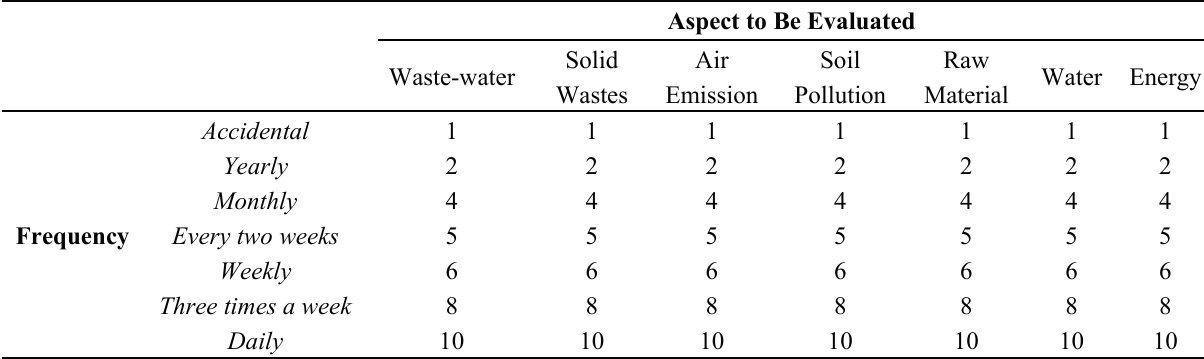
Table 2. Parameter A (Frequency): Numerical values for Parameter A, assigned by the frequency (probability) of occurrence of each event.